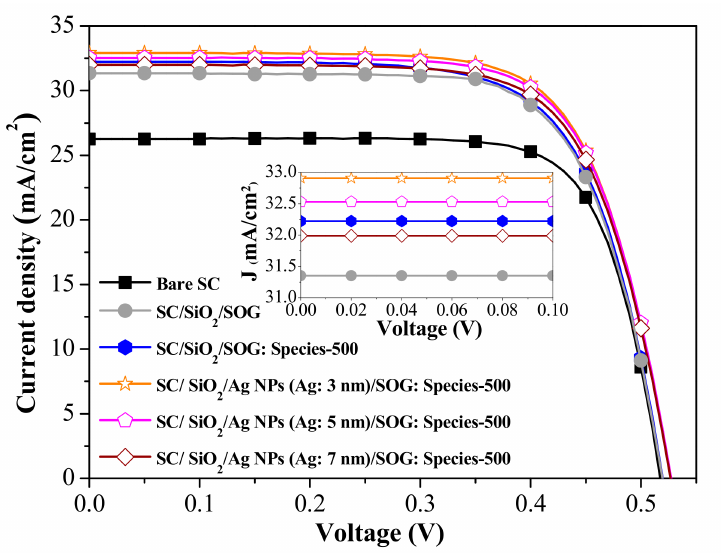
Figure 15. Photovoltaic J-V characteristics of bare silicon solar cell, cell with spacer/SOG, cell with spacer/SOG-phosphors (species-500), and cells with spacer/Ag-NPs/SOG-phosphors